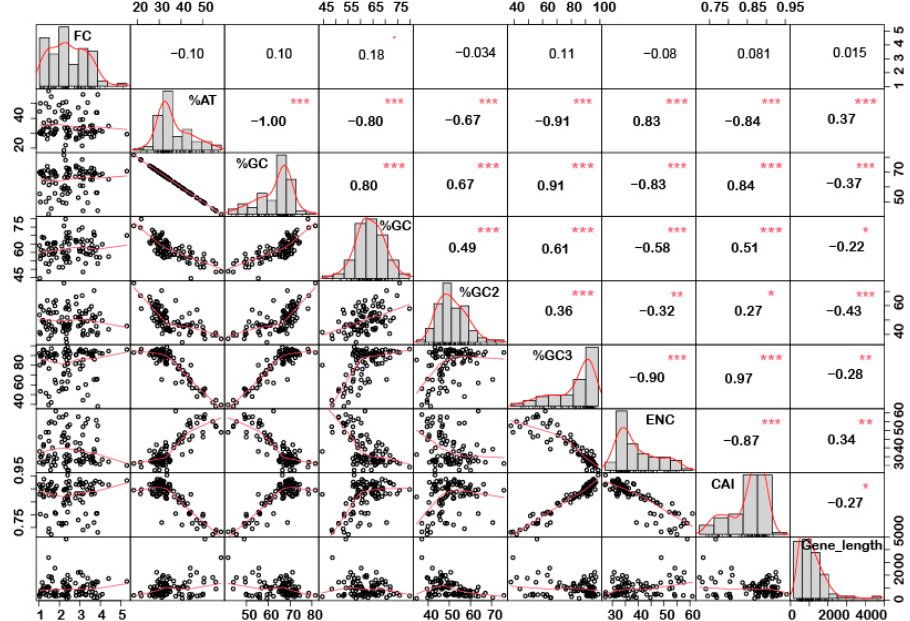
Figure 4. Correlation analysis among nucleotide composition, gene expression, gene length, ENC, and CAI of downregulated genes under biotic stress. Upregulated genes showed a positive correlation between %GC content (at the first, second, and third codon positions) and CAI, while a negative correlation was recorded for gene length and a positive correlation with CAI. Asterisk indicate significant correlation, as *** with a p -value < 0.001, ** with p -value < 0.05 and * with a p -value < 0.01. FC = fold change; ENC = effective number of codons; CAI = codon adaptation index. Table 1. Average %GC, %GC1, %GC2, %GC, CAI, and ENC of upregulated and downregulated genes under abiotic and biotic stress conditions.